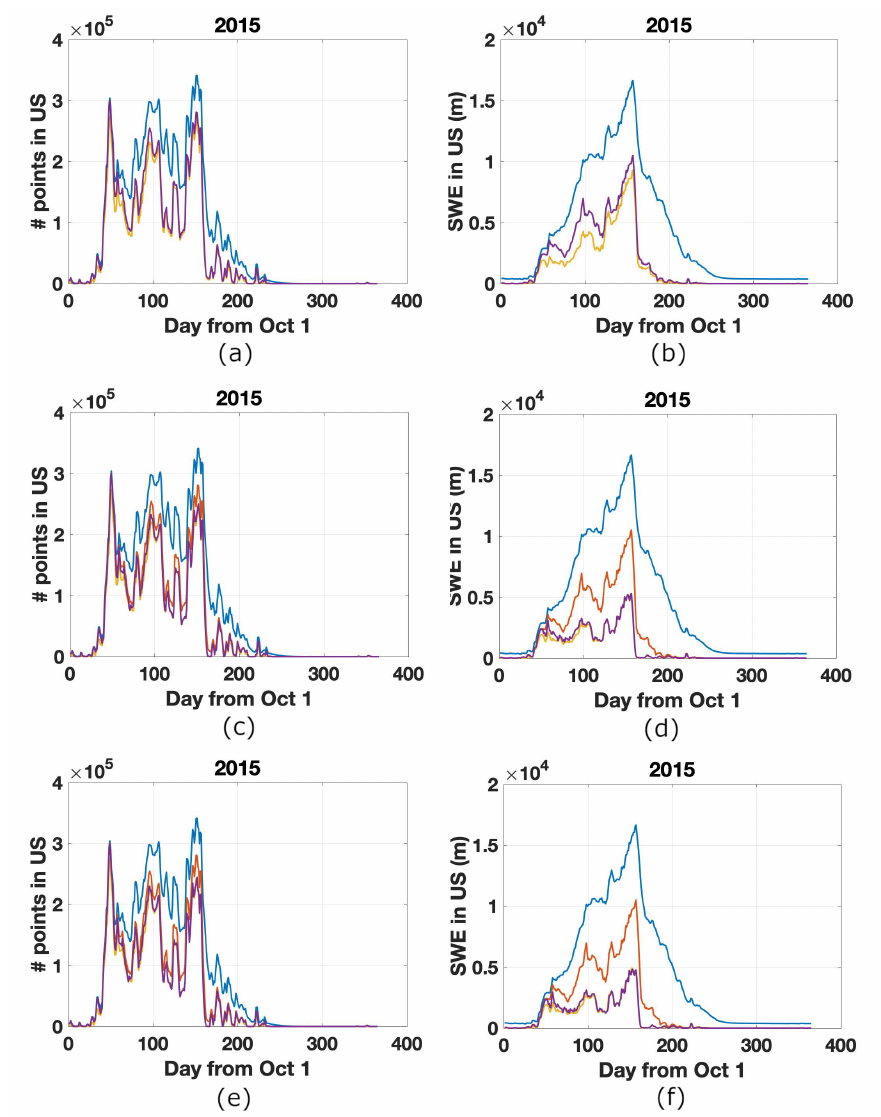
Figure 6. Time series of points in 2015 over US at ( a ) 1 GHz, ( c ) 13.5 GHz, ( e ) 17.25 GHz. Time series of SWE(m) in 2015 over US at ( b ) 1 GHz, ( d ) 13.5 GHz, ( f ) 17.25 GHz. Blue curve shows the time series of all the snow. The red curve shows the time series of dry snow (wetness less than 1%). The yellow line shows the time series of the snow that is dry, lays over flat ground, and has depth larger than the penetration depth (required by the dual-pol. dual-freq. retrieval method). The purple line shows the time series of the snow that is dry, its depth is larger than the penetration depth, and daily interferometric phase change is less than 2 π (required by the differential interferometric retrieval